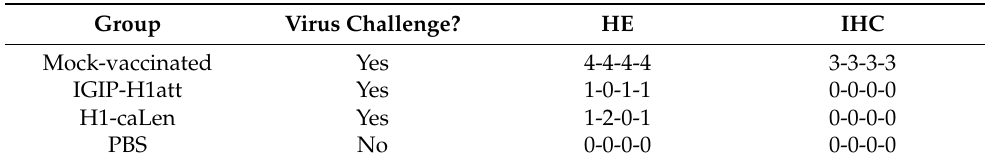
Table 2. Histopathological examination (HE) and immunohistochemistry against IAV scores at 5 dpc in